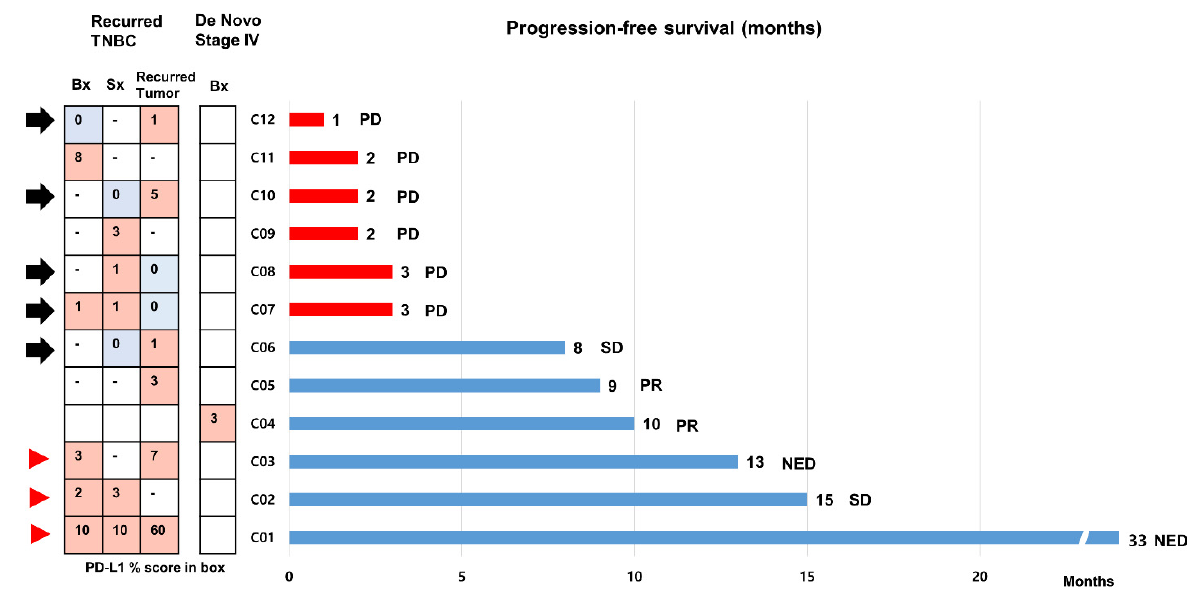
Figure 5. Progression-free survivals of 12 patients with metastatic triple-negative breast cancer treated with first line atezolizumab and nab-paclitaxel. We assessed the progression-free survival (PFSs) of 12 patients with metastatic triple-negative breast cancer (mTNBC) who received first line atezolizumab and nab-paclitaxel using a bar chart. Eleven patients had relapsed mTNBC, except for one patient with de novo mTNBC. Of these, SP142 PD-L1 assays were performed at least twice using archival tissues from primary or recurrent tumors in 7 patients. The black arrow indicates cases with heterogeneity in PD-L1 status across the samples. PFSs were longer than 12 months in 3 patients who had strong, constant PD-L1 positivity across multiple samples (red arrowhead). Abbreviations: NED, no evidence of disease; PD, progression of disease; PR, partial response; SD, stable disease.